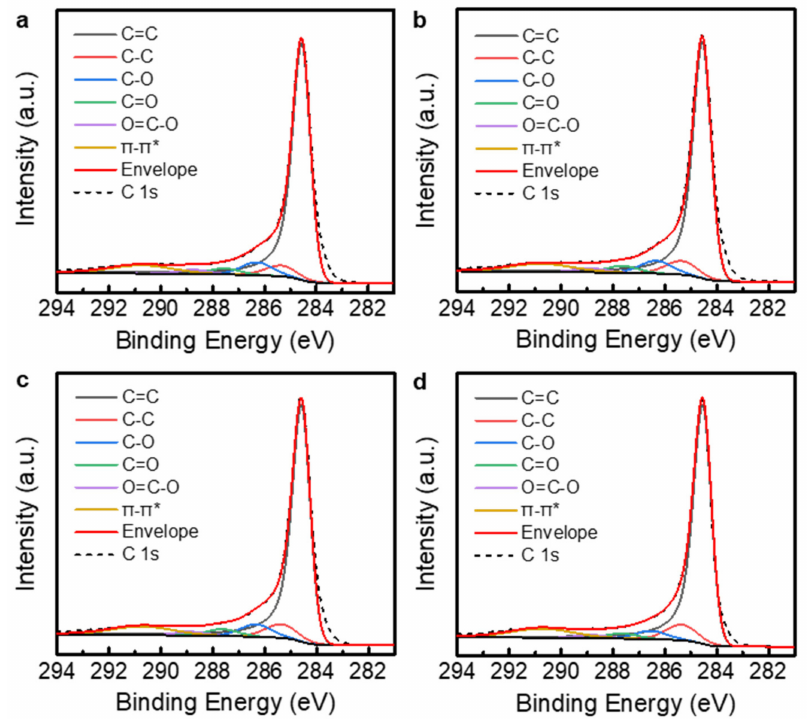
Figure 4. C 1s core-level XPS spectra of TGF600 rGO powders. ( a ) As-received sample. ( b – d ) rGO powders additionally annealed at the temperatures of ( b ) 400, ( c ) 800, and ( d ) 1000 ◦ C.